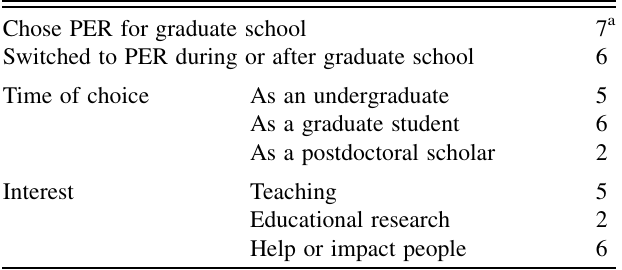
TABLE IV. Participant choice of PER. Chose PER for graduate